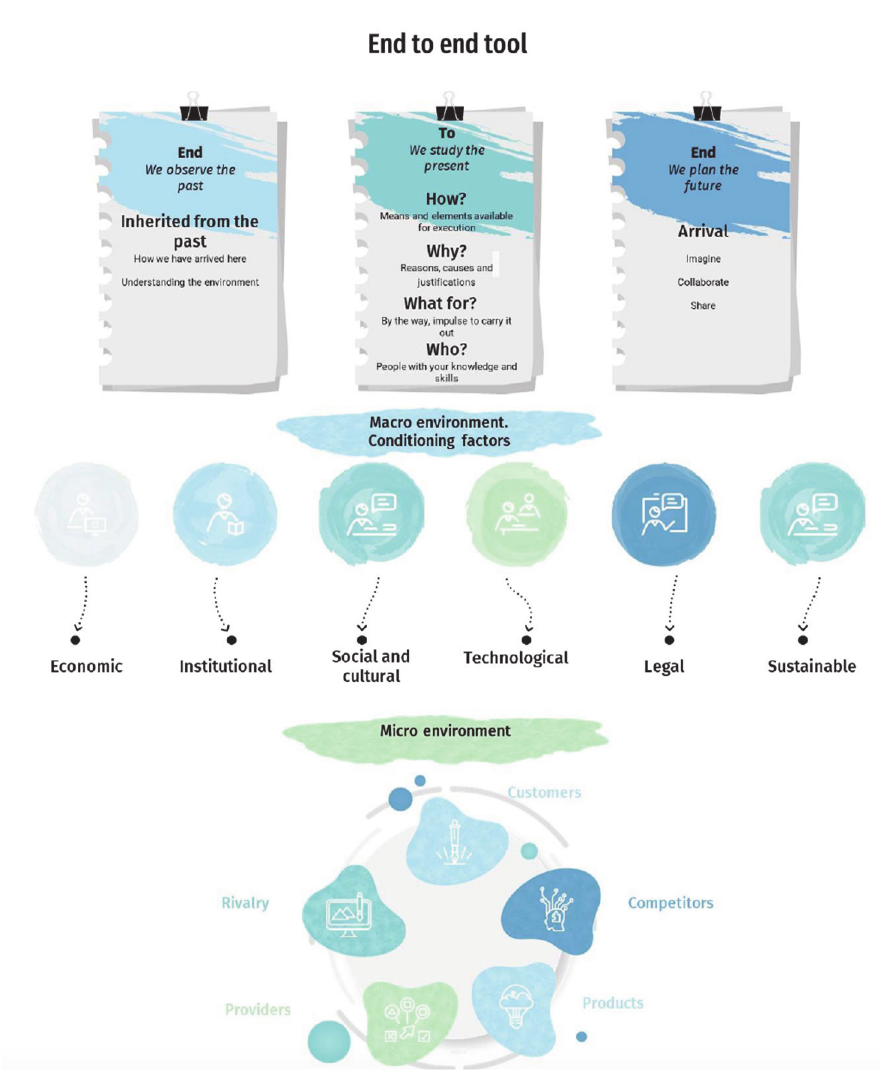
Figure 3. End ‐ to ‐ end tool. Source: own elaboration. Figure 3. End-to-end tool. Source: own